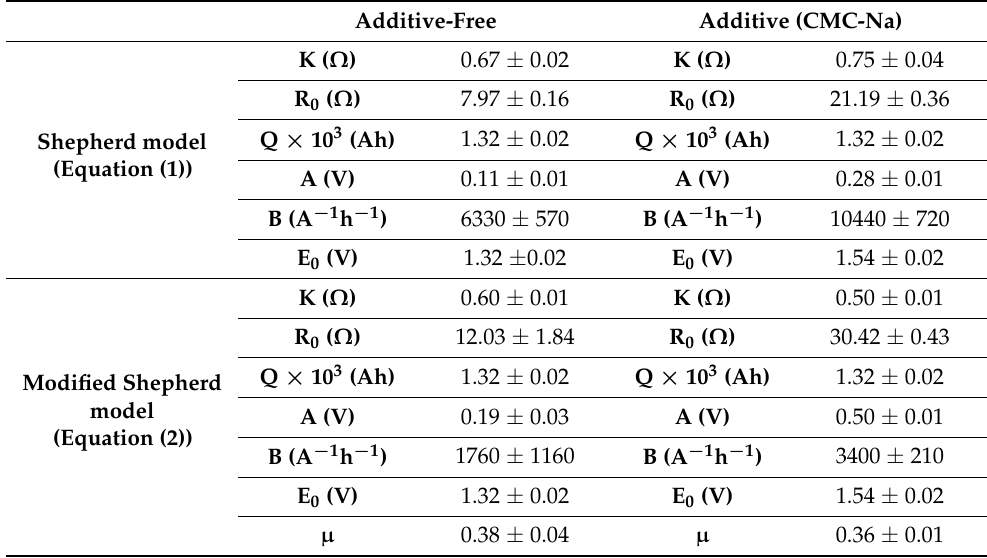
Table 1. The calculated parameters determined by fitting the Shepherd and the modified Shep- herd models. Additive-Free Additive (CMC-Na)